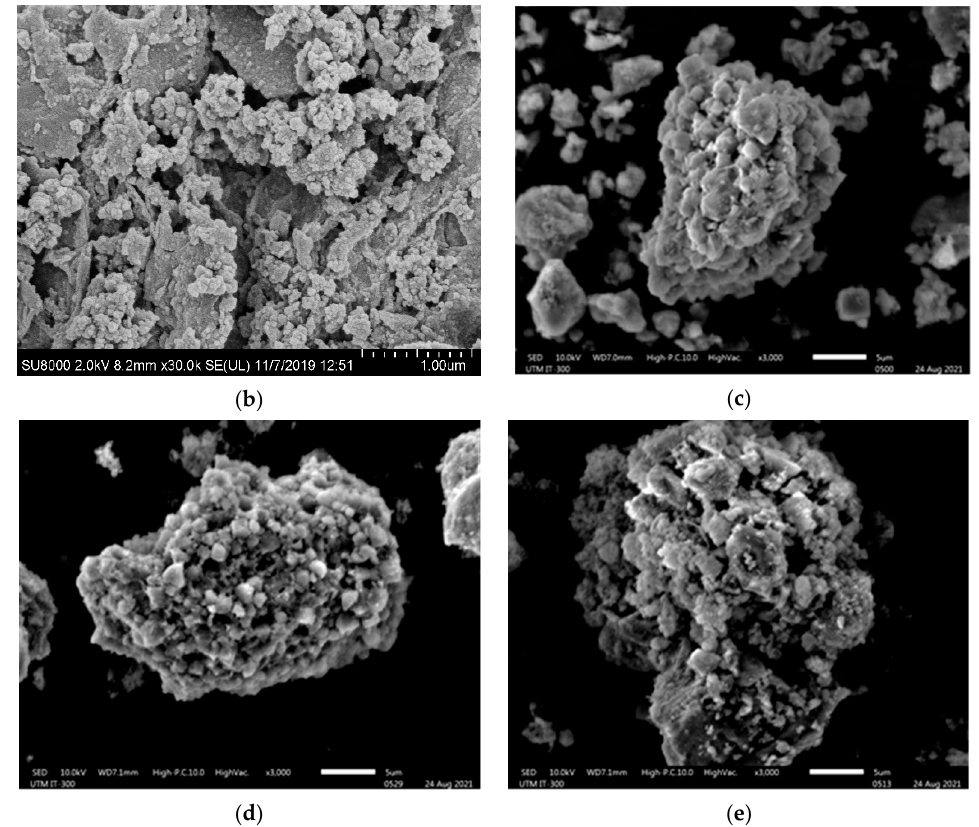
Figure 6. ( a ) Esterification activity of regenerated CRL/SiO 2 /Fe 3 O 4/ GO after ultrasonication and mi- crowave treatments. Next, the SEM micrographs of ( b ) fresh, ( c ) reused, ( d ) ultrasonicated, and ( e ) microwave-treated CRL/SiO 2 /Fe 3 O 4/ GO (3000× magnification).